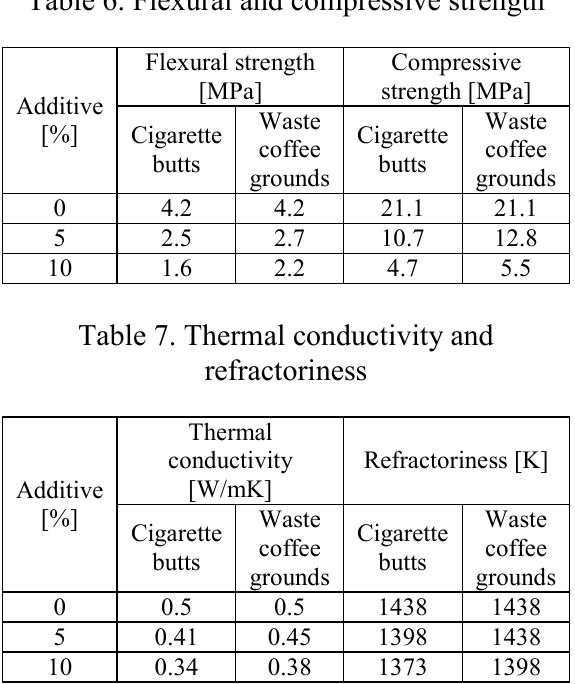
Table 6. Flexural and compressive strength